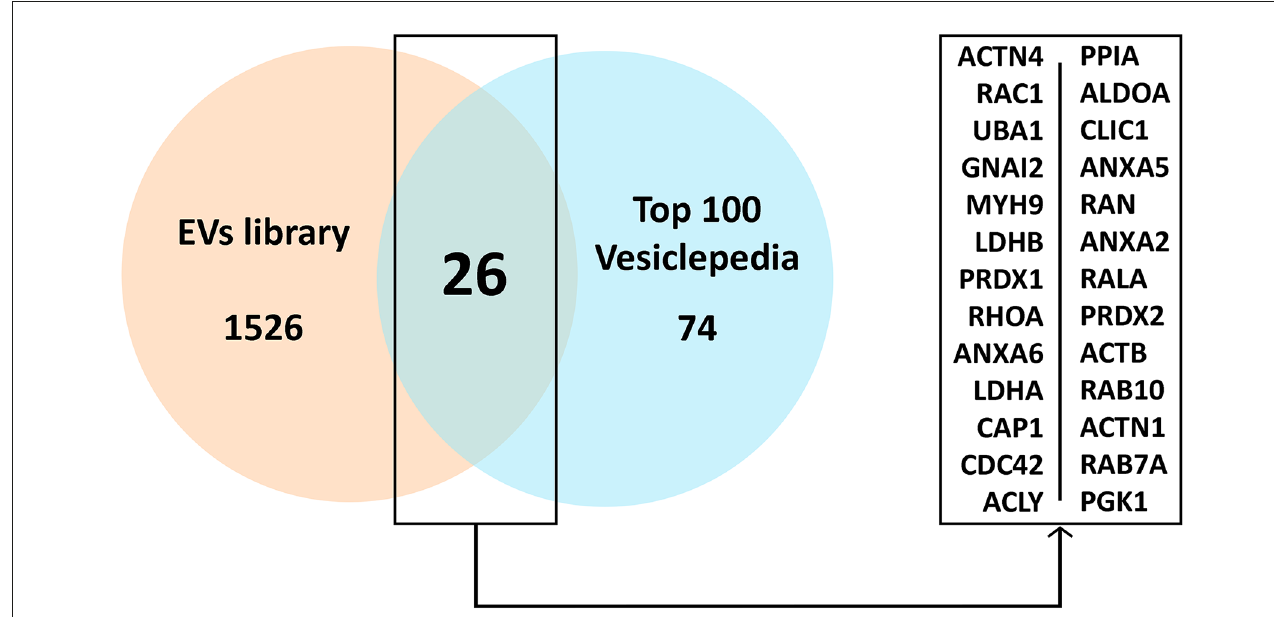
FIGURE4 Common proteins present in the EVs study sample compared to the top 100 proteins in Vesiclepedia. Abbreviations: EVs, extracellular vesicles.